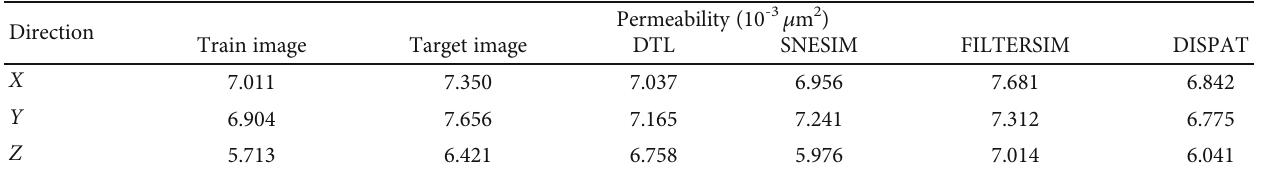
Figure 21: MPC curves (sandstone) of the TI, the target image, and reconstructed images using SNESIM, FILTERSIM, DISPAT, and DTL. Table 3: Permeability (shale) of the TI, the target image, and average permeability of ten reconstructed images in three directions using DTL, SNESIM, FILTERSIM, and